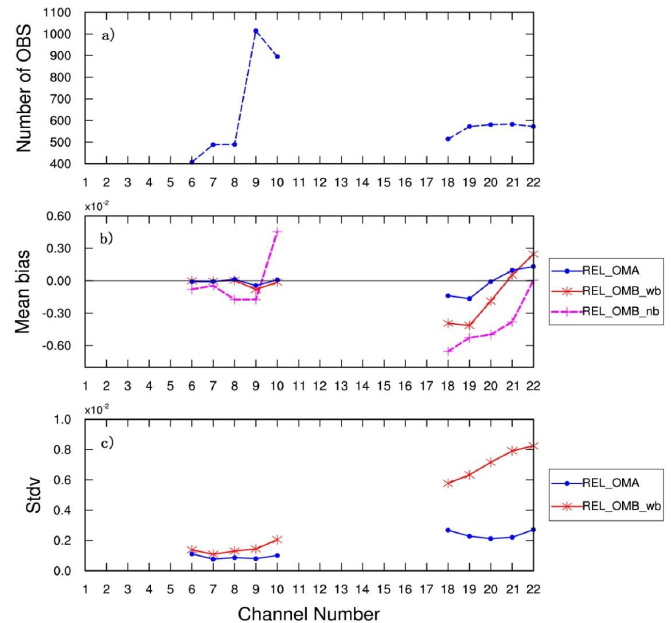
Figure 5. The observation numbers ( a ) used in data assimilation and the statistics of the relative departures for ATMS different channels. ( b ) Mean bias and ( c ) standard deviation of the relative background departures with (REL_OMB_wb) and without (REL_OMB_nb) bias correction, and the relative analysis departures (REL_OMA) against the observed brightness temperatures at 1800 UTC July 18, 2016.